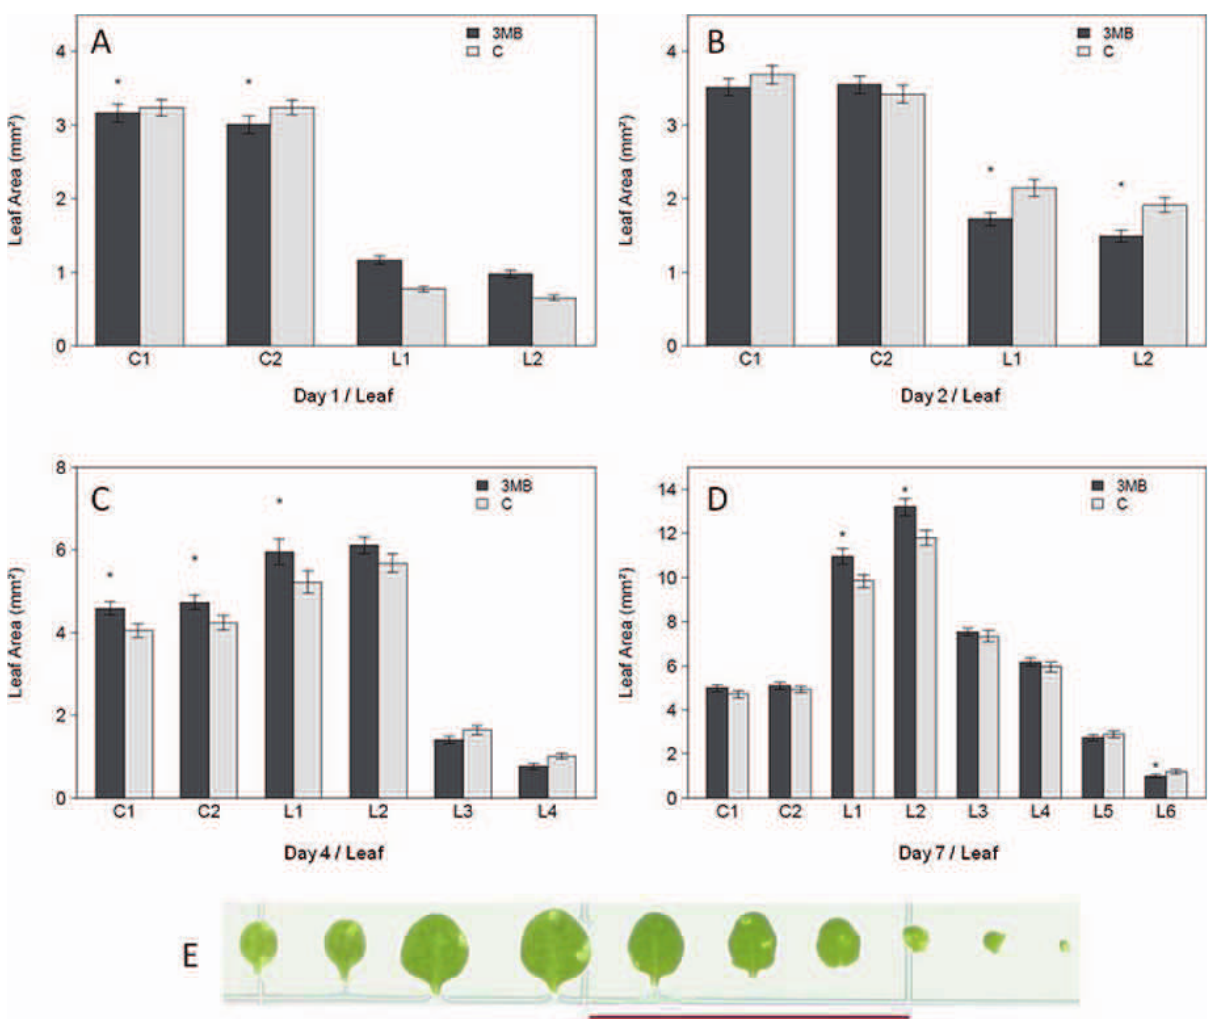
Figure 2. Altered leaf growth in response to PARP inhibition. (A–D) Rosettes harvested at the indicated time points were dissected and the single leaf size was measured by ImageJ with (C) indicating cotelydone and (L) indicating leave. 15–25 seedlings were analyzed in an experiment, repeated in four independent experiments (n=90). Significant differences (P , 0.05) between treated and untreated plants is indicated by asterisks. (E) A typical leaf series of 14 day old plants (day7) is shown. The red bar indicates 2